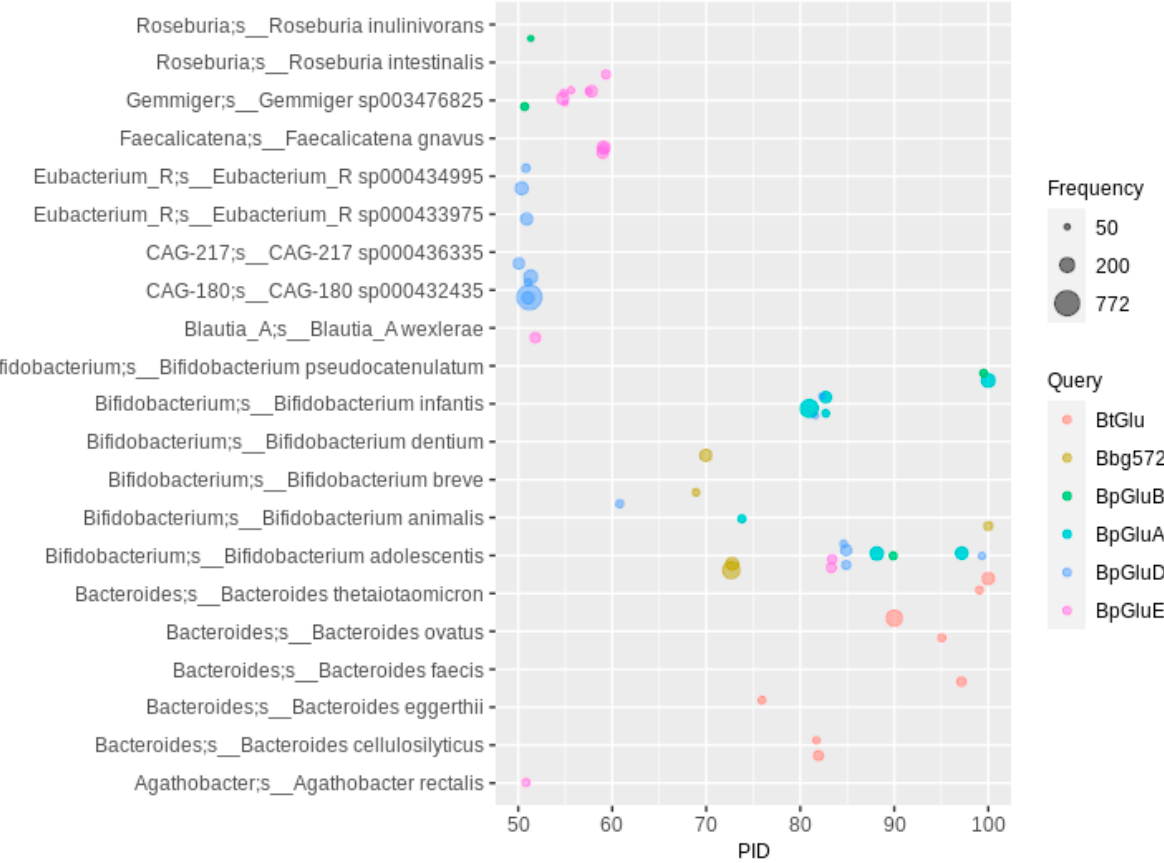
Figure 1. Flavonoid O -glycosidase homologs in human gut MAGs. The PID (percent amino acid sequence identity) threshold to the queries (see color code) was set to 50 (For abbreviations and details, see Table 1). Hits were filtered for at least 50 occurrences, so that each bubble represents a number of redundant sequences ranging from 50 to 772.